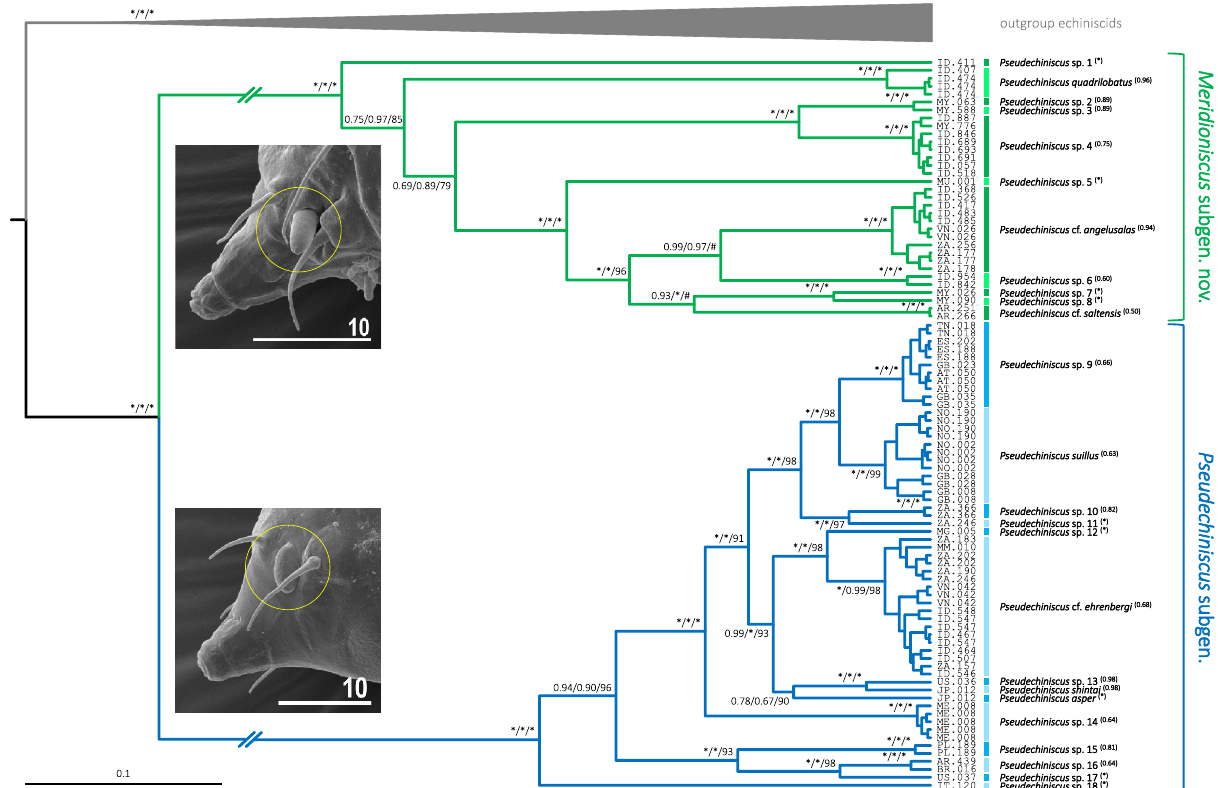
Figure 2. Phylogeny of the genus Pseudechiniscus based on the concatenated matrix (18S rRNA+28S rRNA+ITS-1). Values at nodes separated by forward slashes signify BEAST Bayesian posterior probability (BI), MrBayes Bayesian posterior probability, and bootstrap values (ML), respectively. Maximum supports, i.e. 1.00 for BI and 100 for ML, are indicated by asterisks. Support values for tip nodes (within intra-specific phylogenetic structure) are not shown for simplicity. Topologies of all consensus trees were identical, with the exception of a single clade, in which ML gave incongruent results (marked with hashtags). The scale refers to the BEAST consensus tree. Values in round brackets and in the superscript at each species name refer to the support they received in the bPTP delimitation method (maximum values, i.e. 1.00, are indicated by asterisks). Exemplary SEM microphotographs show the dactyloid papillae in Meridioniscus subgen. nov. ( Pseudechiniscus (M.) cf. angelusalas ) and pseudohemispherical papillae in the subgenus Pseudechiniscus ( Pseudechiniscus (P.) cf. ehrenbergi ). Scale bars in the photos in